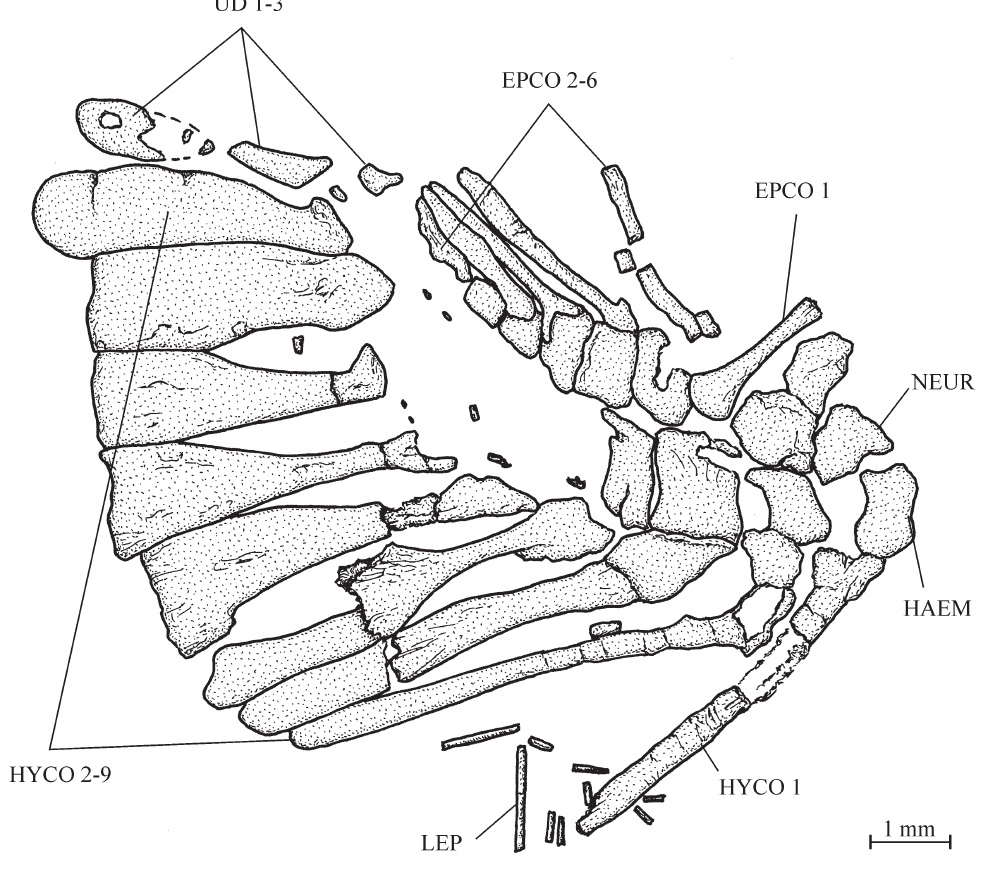
Fig. 22. Brembodus ridens Tintori, 1980. Caudal skeleton of sample CLC